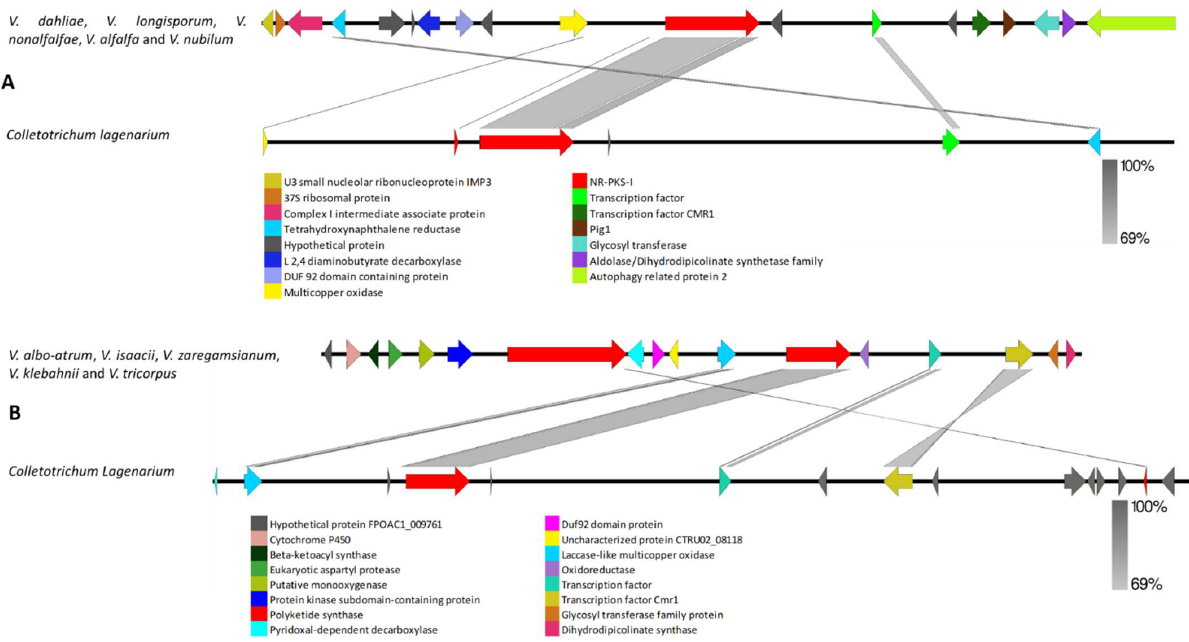
Figure 4. Comparison of putative cluster genes for Verticillium VNR-PKS-I-1 and the DHN melanin- producing PKS. ( A ) Putative VNR-PKS-I-1 cluster of V. dahliae , V. longisporum , V. nonalfalfae , V. alfalfae and V. nubilum compared to Colletotrichum lagenarium DHN melanin cluster ( B ) Putative biosynthetic cluster for V. albo-atrum , V. isaacii , V. zaregamsianum , V. klebahnii and V. tricorpus gene compared to C. lagenarium DHN melanin cluster. The arrowheads indicate the direction of transcription and the types of genes common to the two clusters being compared are displayed in the same color. Shaded lines represent similarities between nucleotide sequences.